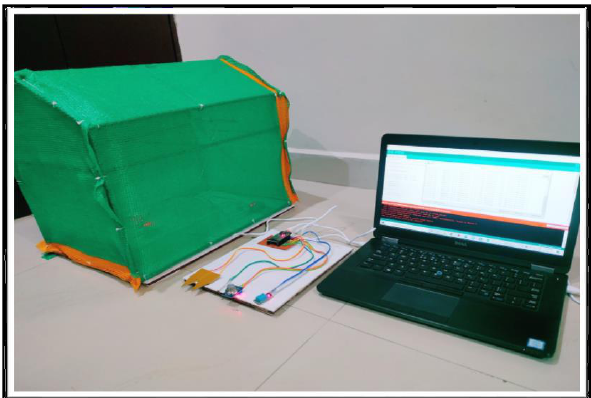
Figure 7. Experimental testbench.